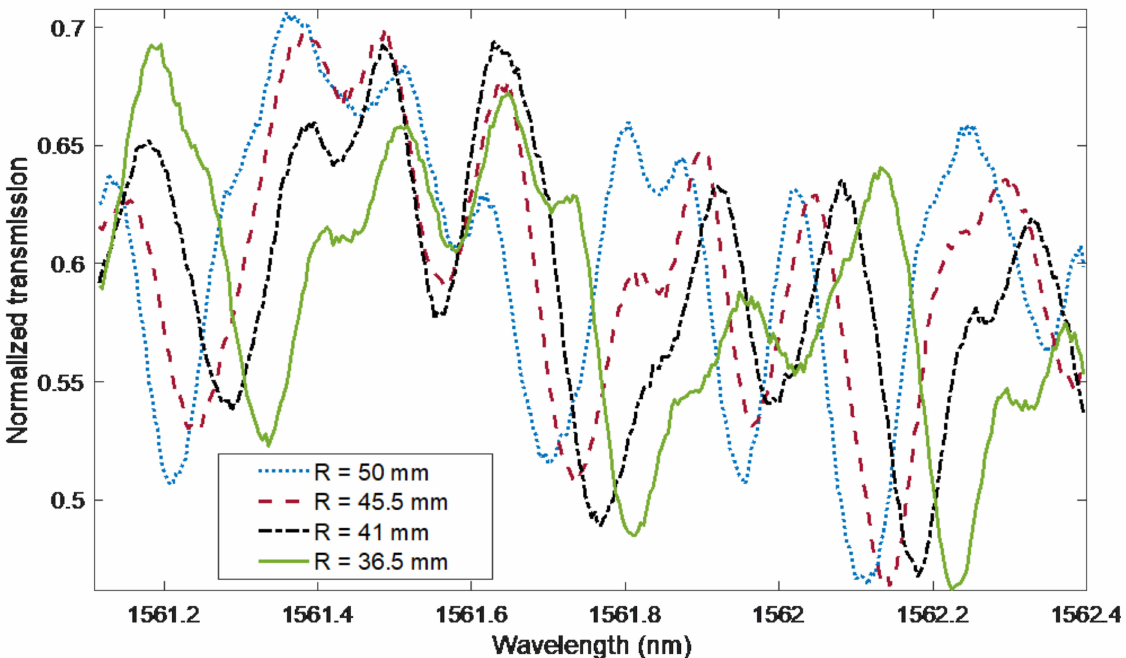
Figure 10. Bending effect on wavelength shift in the 1561.1 to 1562.4 nm range. Reducing the radius shifts part of the spectrum towards longer